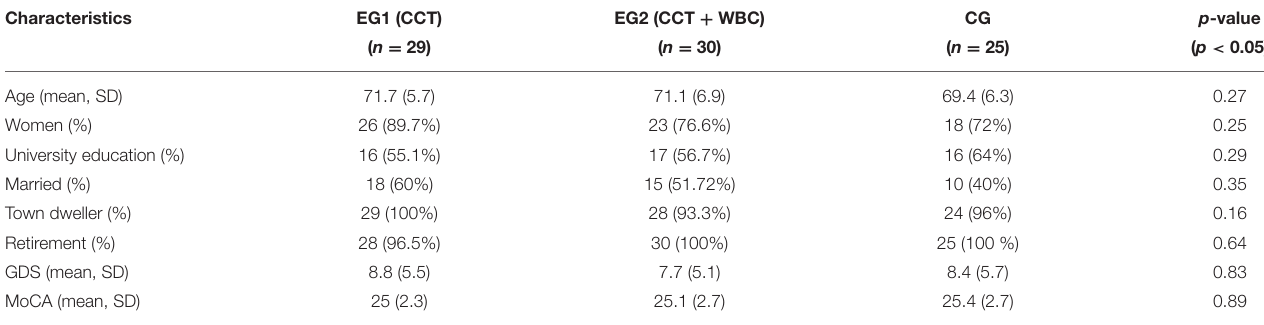
TABLE 1 | Baseline characteristics of the participants.